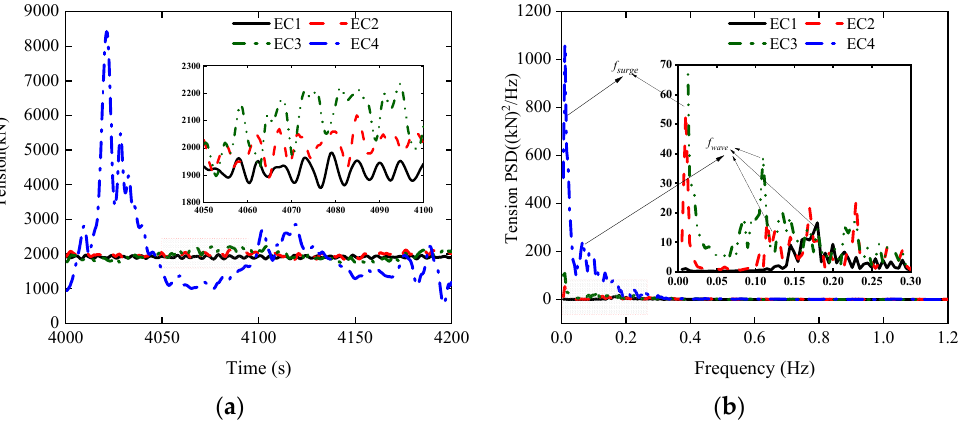
Figure 9. Time histories and spectra of the #1 tension under real environmental conditions: ( a ) Time histories of the #1 tension; ( b ) Spectra of the #1 tension.